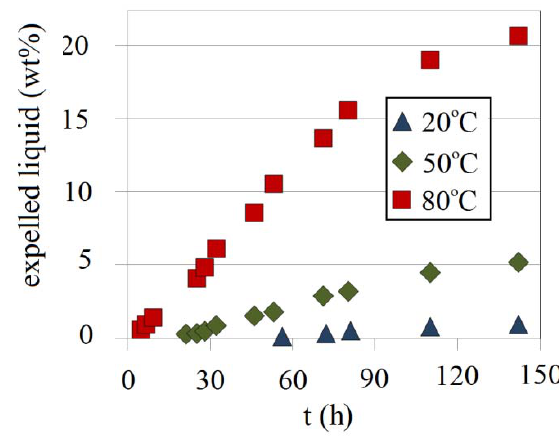
Figure 26. Weight percent of the expelled liquid as a function of time for 4.5 wt% Na-silicate solution with pH 10.30 at 20 °C, for various CaCl